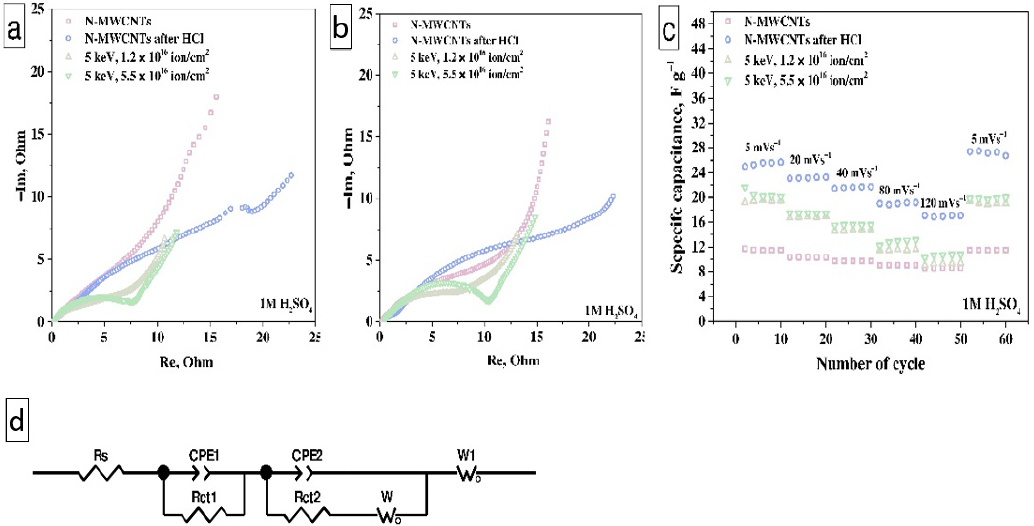
Figure 8. Nyquist plot before ( a ) and after cycling (60 cycles) ( b ), the cycling at different scan rates ( c ), the equivalent circuit ( d ) for electrodes based on N-MWCNTs before and after